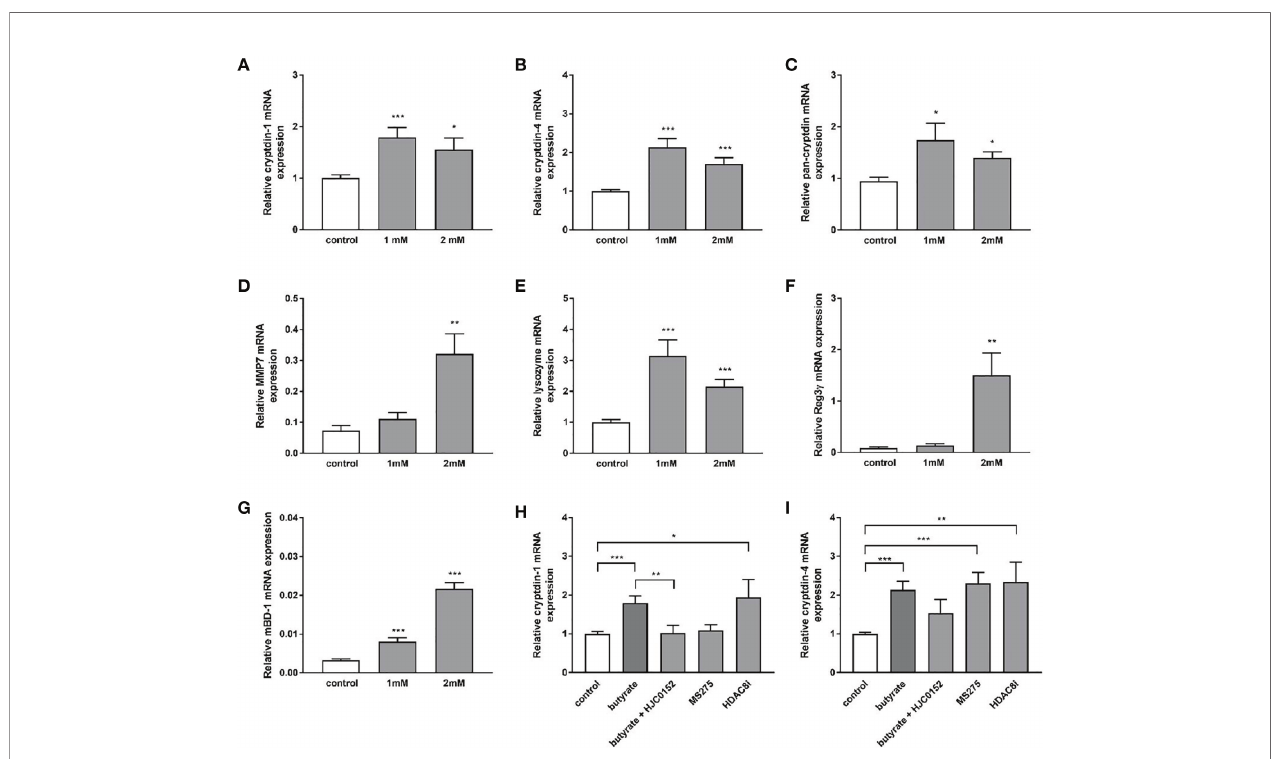
FIGURE 8 | Sodium butyrate induces expression of antimicrobial peptides in murine organoids in vitro . Organoids were treated with 1mM and 2mM sodium butyrate for 30h. Relative mRNA expression level of cryptdin-1 (A), cryptdin-4 (B), pan-cryptdin (C) , MMP7 (D) , lysozyme (E) Reg3 g (F) , mBD-1 (G) determined by quantitative RT-PCR derived in organoids from the small intestine of healthy C57BL/6 mice (n=6). Organoids were treated with sodium butyrate (1mM), sodium butyrate in combination with HJC0152 (5 m M) or MS-275 (2 m M) or HDAC8-IN-1 (0.5 m M). Relative mRNA expression level of cryptdin-1 (H) and cryptdin-4 (I) determined by quantitative RT-PCR derived in organoids from the small intestine of healthy C57BL/6 mice (n=3-6). Data are presented as means ± SEM and were analyzed by unpaired t-test (A – G) or one-way ANOVA with Sidak´s post-test (H, I) . Signi fi cant differences are indicated as *p-value < 0.05; **p-value < 0.01; ***p-value <